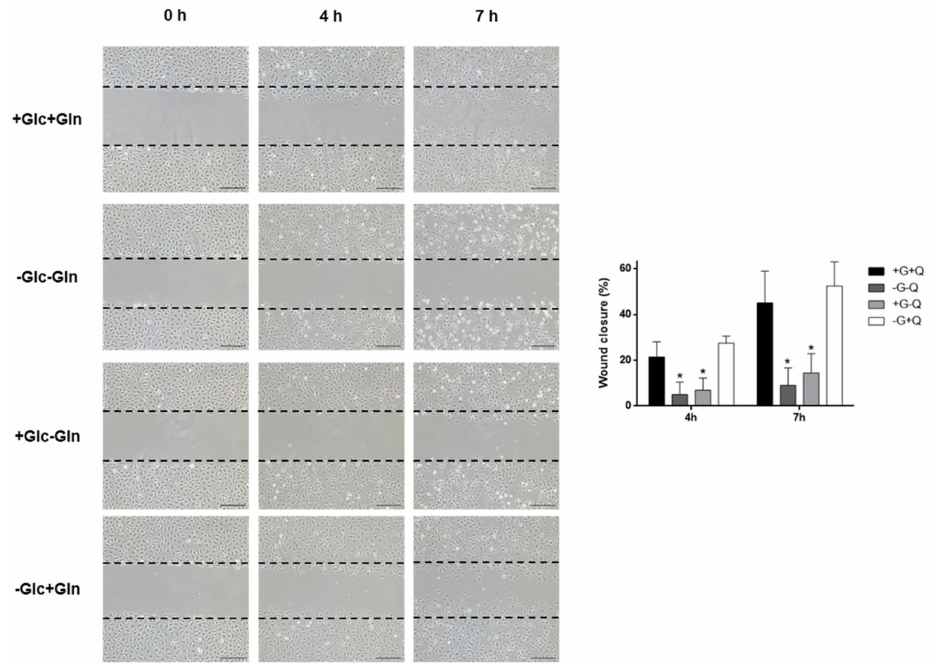
Figure 3. HMEC migration under di ff erent nutritional conditions. Representative images and quantification of wound closure of cells incubated in the presence or absence of 5 mM glucose (G) and / or 0.5 mM glutamine (Q) for 0, 4, and 7 h (scale bar = 200 µ m). Data are expressed as means ± SD of three independent experiments. * p < 0.05 versus condition with glucose and